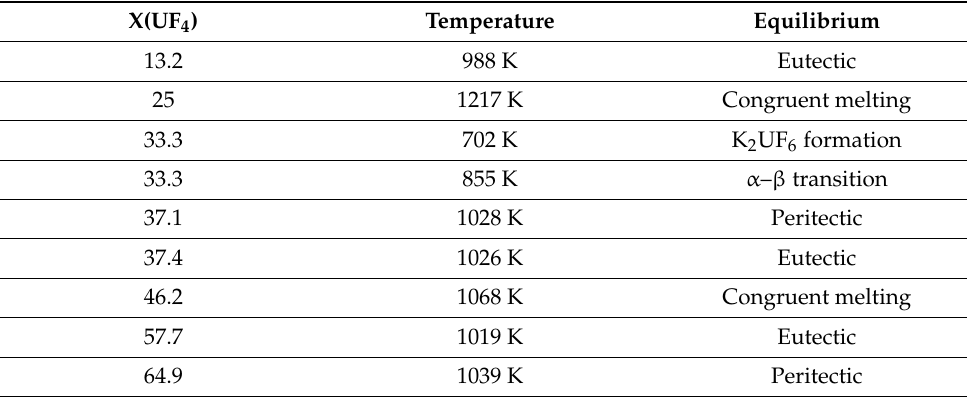
Table 7. Invariant equilibria obtained from the calculated KF-UF 4 phase